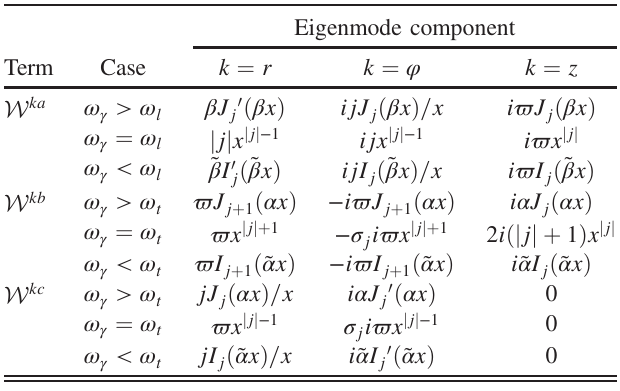
TABLE X. Fiber eigenmodes: Terms in the radial partial wave W γ of the displacement eigenmode in Eq. (C16). The radial dependence is given by Bessel functions J functions I of the first kind. The prime indicates the first j derivative J 0 ð x Þ ¼ ∂ x J j ð x Þ . All remaining quantities are defined j in Table IX.